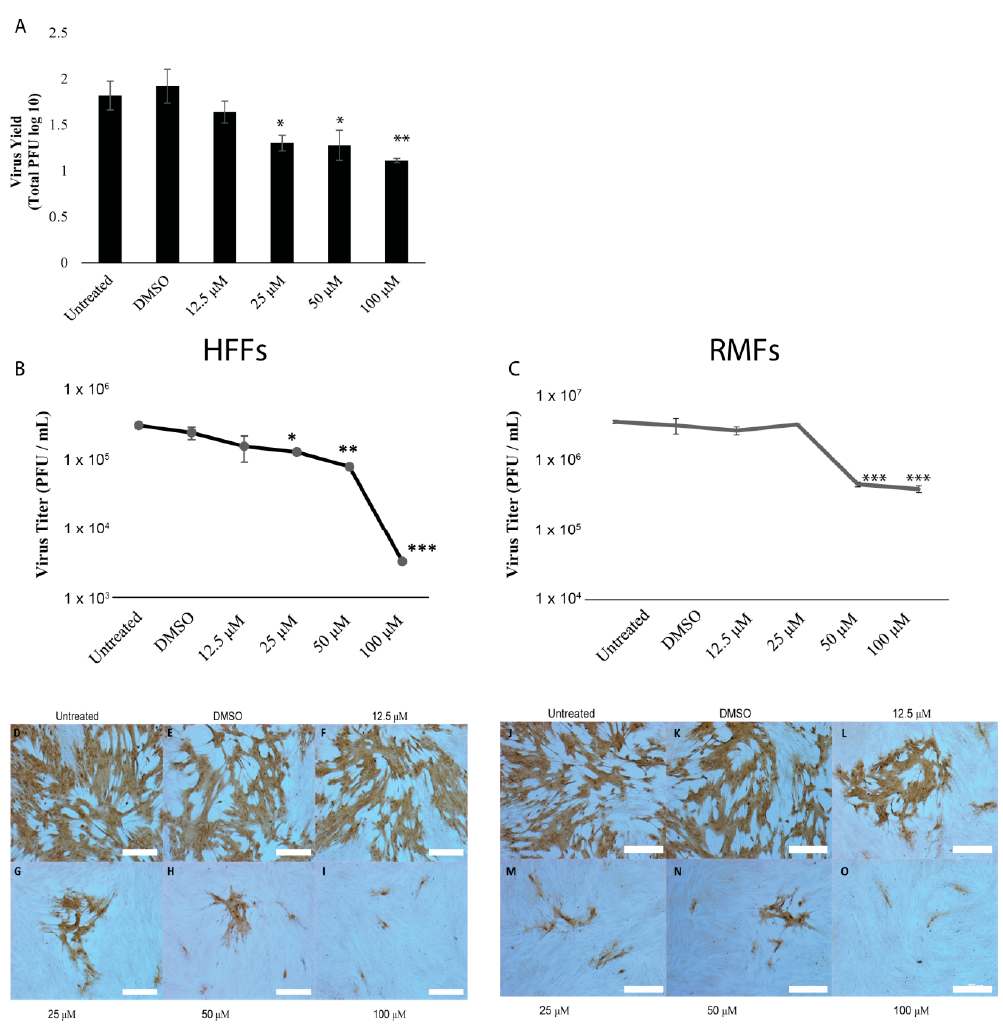
Figure 2. Genistein has antiviral activity against B virus in human and macaque fibroblasts. HFFs and RMFs were left untreated (negative control) or treated with either 1% DMSO (experimental control) or increasing concentrations of genistein and infected with 150 PFU of B virus for 48 h. ( A ) Indirect virus yield assay in HFFs. After 48 h, cells / supernatants were harvested and back-titered on Veros. Data shows total PFU counted in Veros. Cell-based Elisa in HFFs ( B ) and RMFs ( C ). After 48 h, cells were fixed with 100% methanol and assayed via ELISA for amount of virus antigen. An in-assay standard curve was generated to calculate virus titer and IC 50 values were calculated using a logarithmic regression line. Statistical analysis performed via one-way ANOVA with Dunnet’s correction for multiple comparisons. N = 9. Error bars show standard error of the mean. * p = < 0.05, ** p < 0.01, *** p =< 0.001. Direct virus yield assay in HFFs ( D – I ) and RMFs ( J – O ). After 48 h, cells were fixed with 100% methanol and virus antigen was visualized via IHC with DAB detection. Scale bars shown at 200 µ M.3.3. Genistein Targets B Virus Post-Viral Entry and Genomic